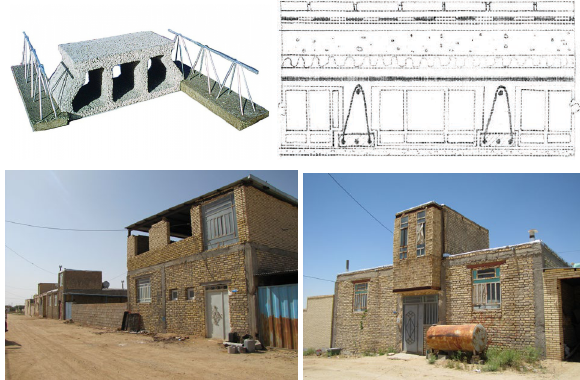
Figure 21. From up; Block joist, two examples of contemporary houses, author.